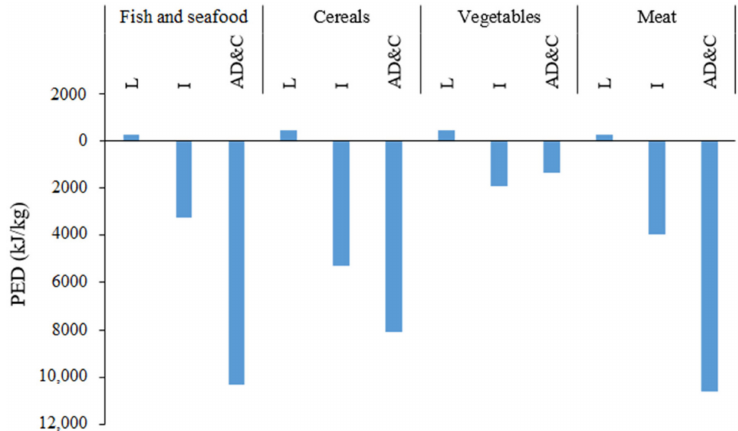
Figure 8. Primary energy demand values for the considered scenarios expressed in kilojoules per